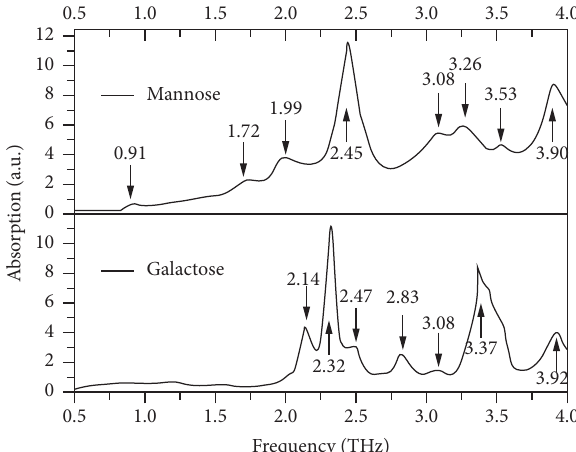
Figure 3: The comparison of the experimental terahertz absorption spectra of mannose and